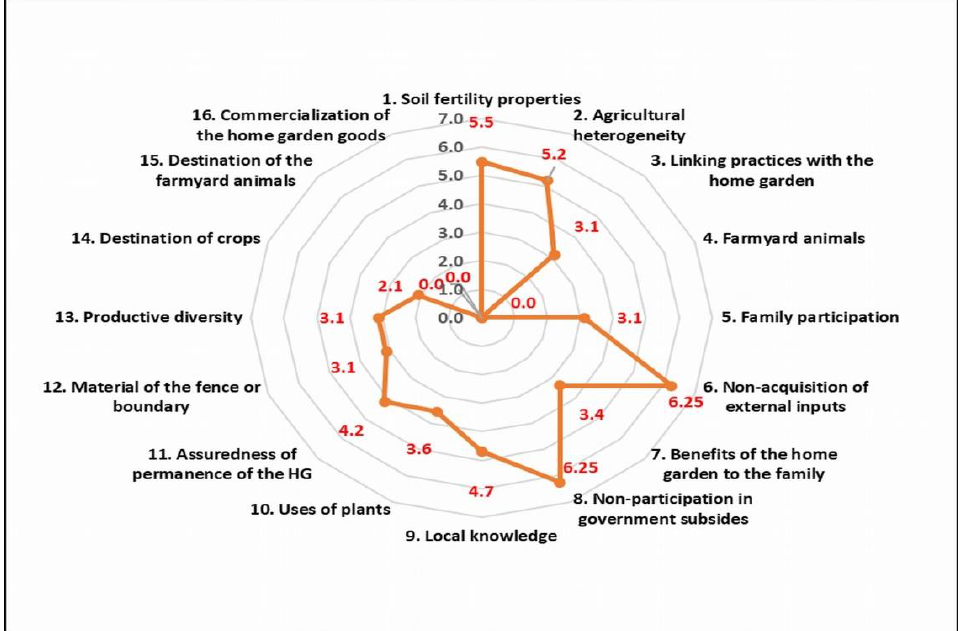
Figure 6. Average value per indicator of home gardens with intermediate sustainability.